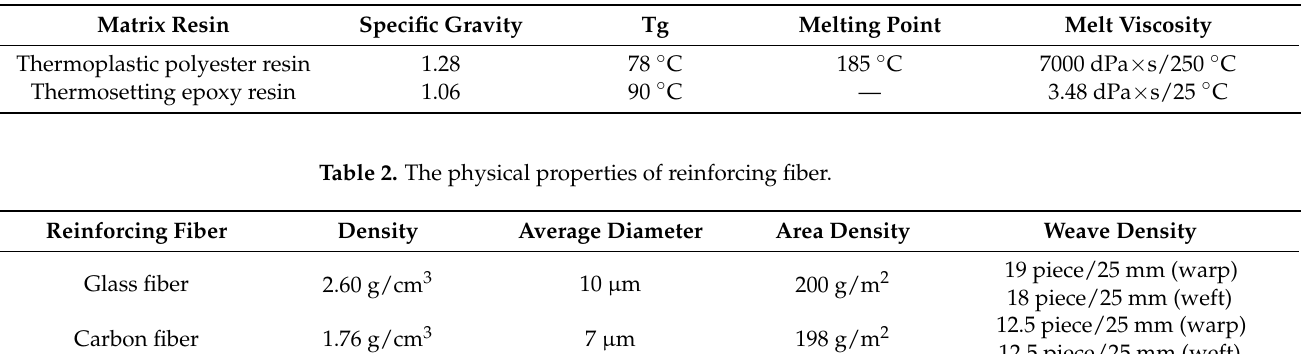
Table 1. The physical properties of matrix resin.